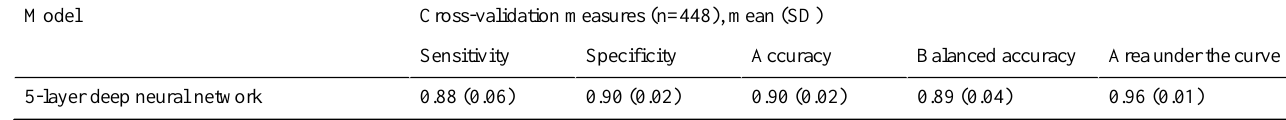
Table 4. Cross-validation results.